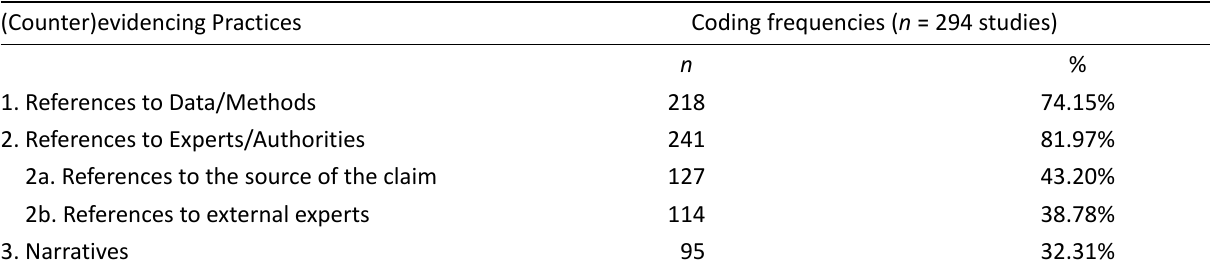
Table 2. Frequencies of (counter)evidencing practices. (Counter)evidencing